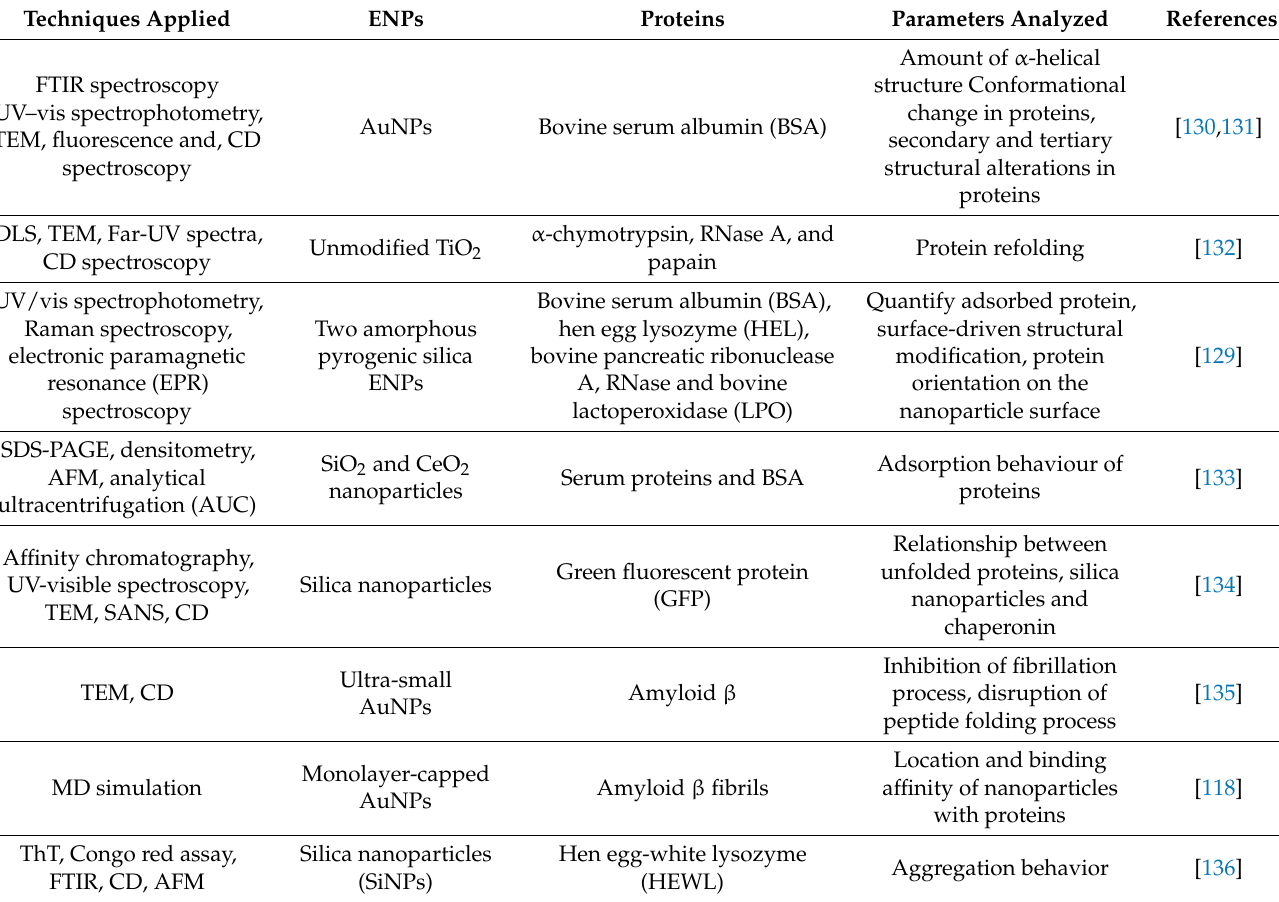
Table 4. ENP-protein interaction studies done using various